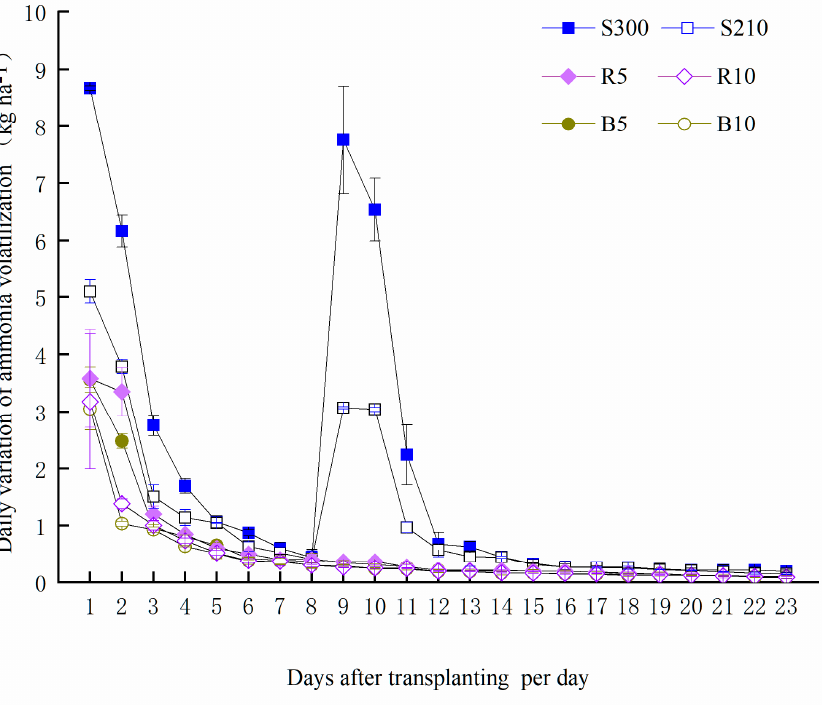
Figure 5. Daily variation of ammonia volatilization in different fertilization treatments.